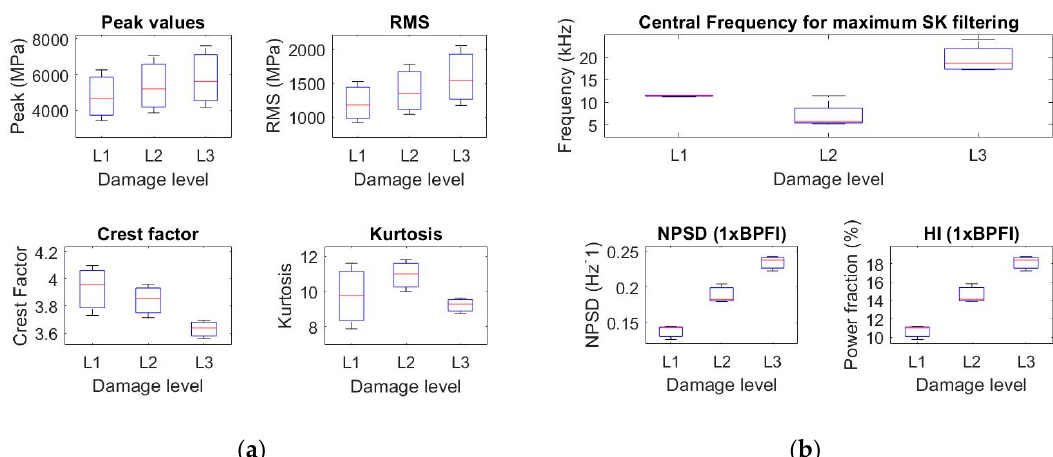
Figure 20. Boxplots for the features extracted from the pressure signal: ( a ) peak value, root mean square (RMS), crest factor (CF) and kurtosis (K) and ( b ) central frequency of the maximum spectral kurtosis (SK) band, 1x BPFI content in the NPSD and HI in the 1x BPFI .